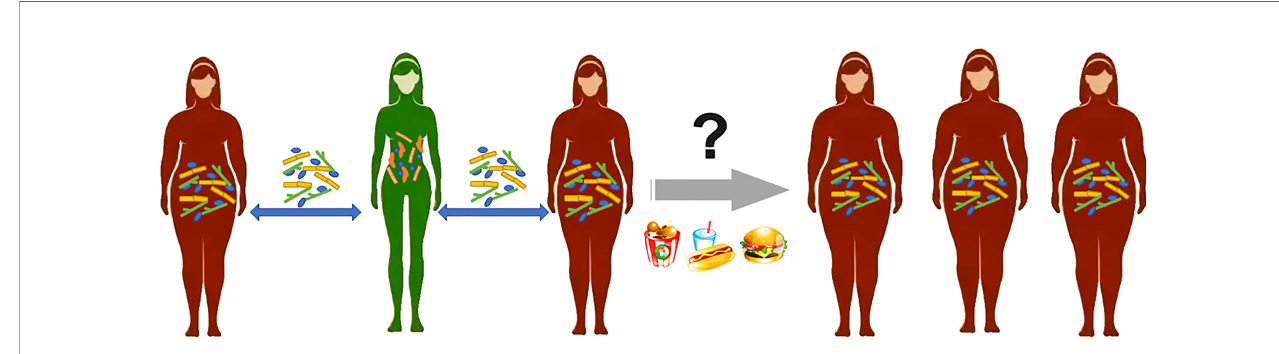
FIGURE 1 | A person ’ s chances of becoming obese increased by 57% if he or she had a friend who became obese in a given interval. Gut microbiota between friends may be a risk factor for obesity, but it is dif fi cult to isolate from dietary and